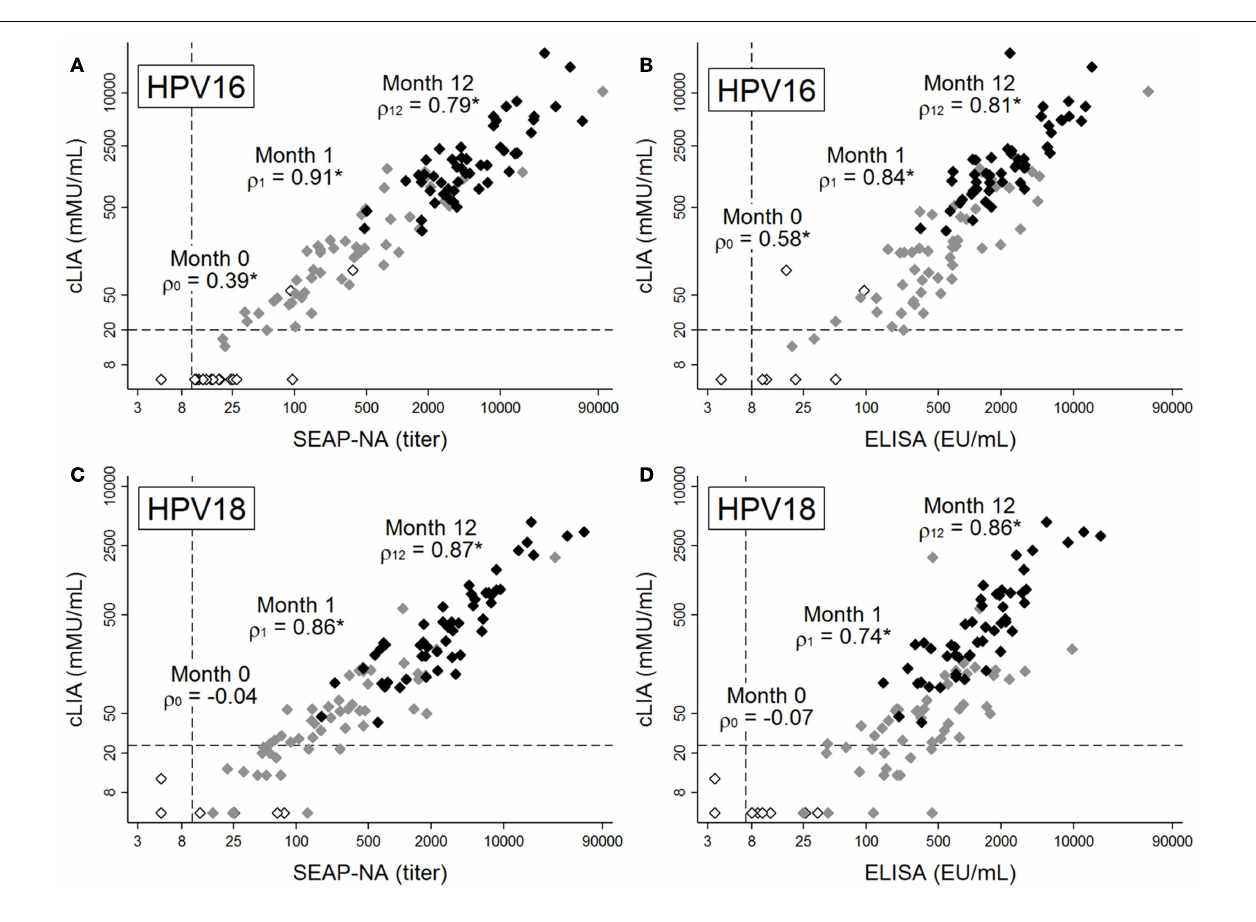
correlation coefficients between pairs of assays are displayed for each time point, with asterisks denoting statistical significance (all p < 0.005). Dashed lines represent laboratory-determined seropositivity cutoffs. Note differing scales for x - and y -axes, as assays use different scales for